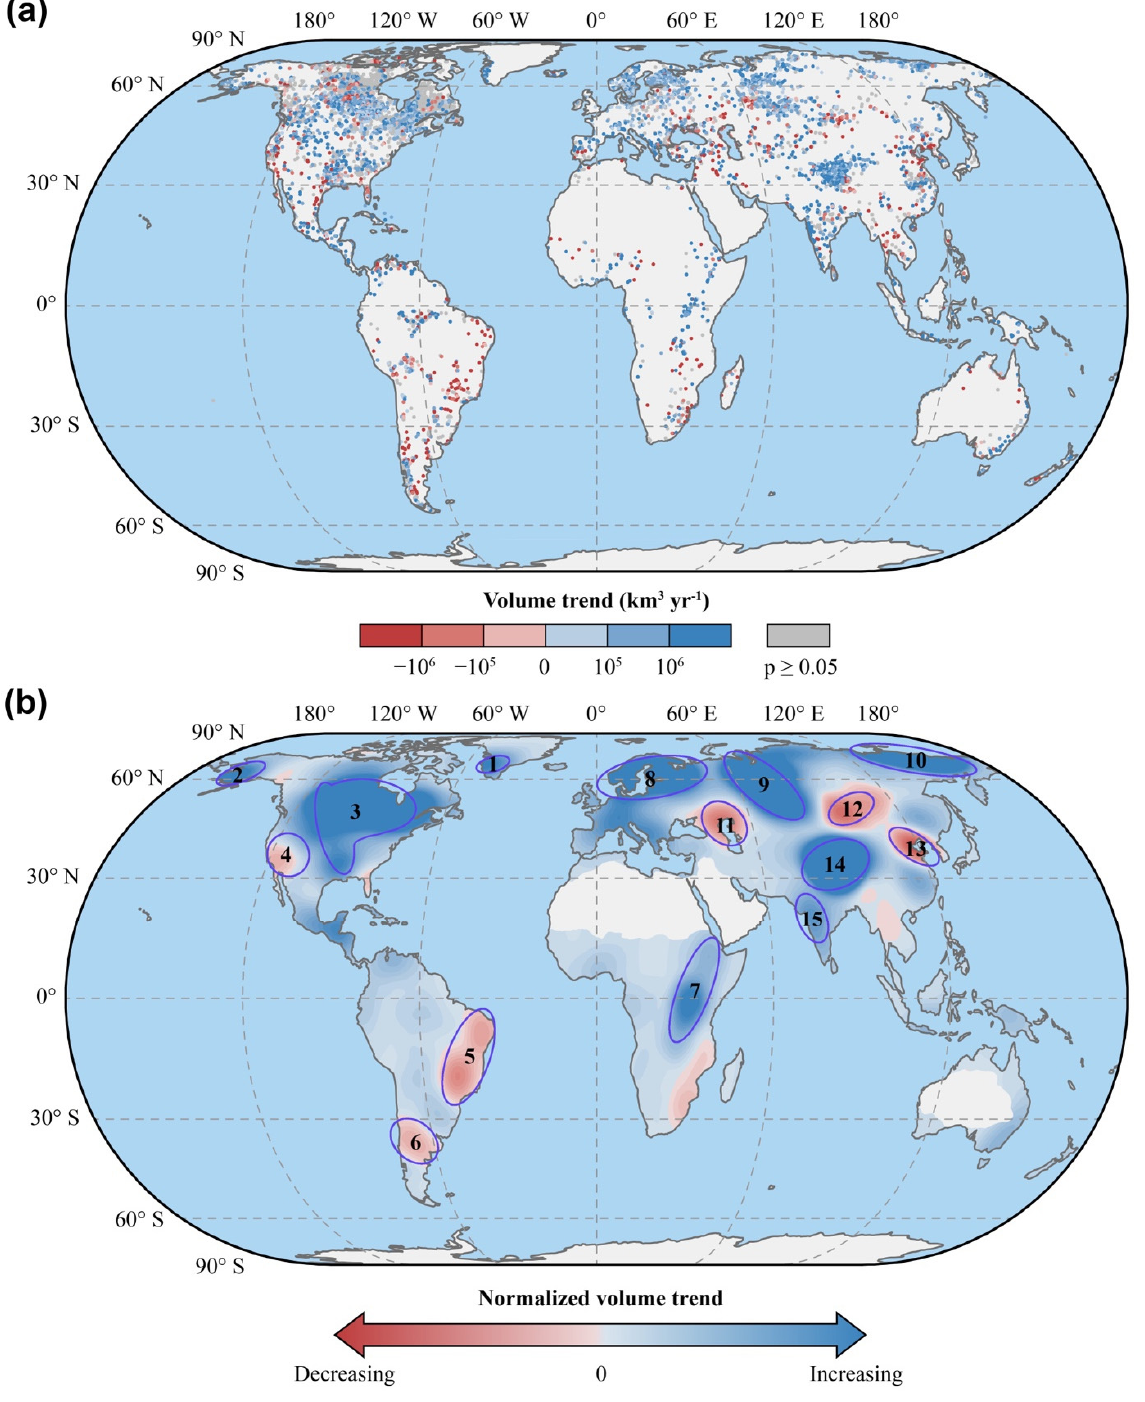
Figure 2. Changes in lake volume at the global scale in the period of 2003–2020. ( a ) Trends in monthly lake volume from 2003 to 2020 for 9065 lakes: the trends were calculated using the seasonal Kendall method to remove the seasonal amplitude of lake volume. ( b ) Hot spots of lake volume change: trends in lake volume of individual lakes were normalized and smoothed spatially via the kernel density method (Equations (12) and (13)). Hot spots dominated by increasing trends in lake volume are shown in blue and those dominated by decreasing trends are shown in red.